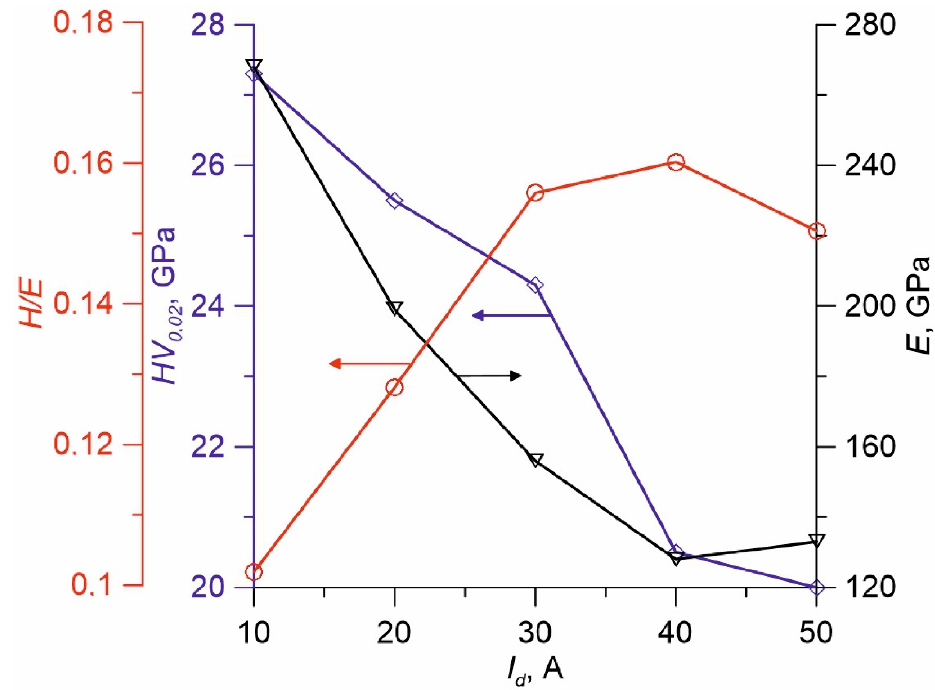
Figure 8. HV (blue), Young’s modulus (black) and H/E (red) of TiSiCN coatings on discharge current I d .